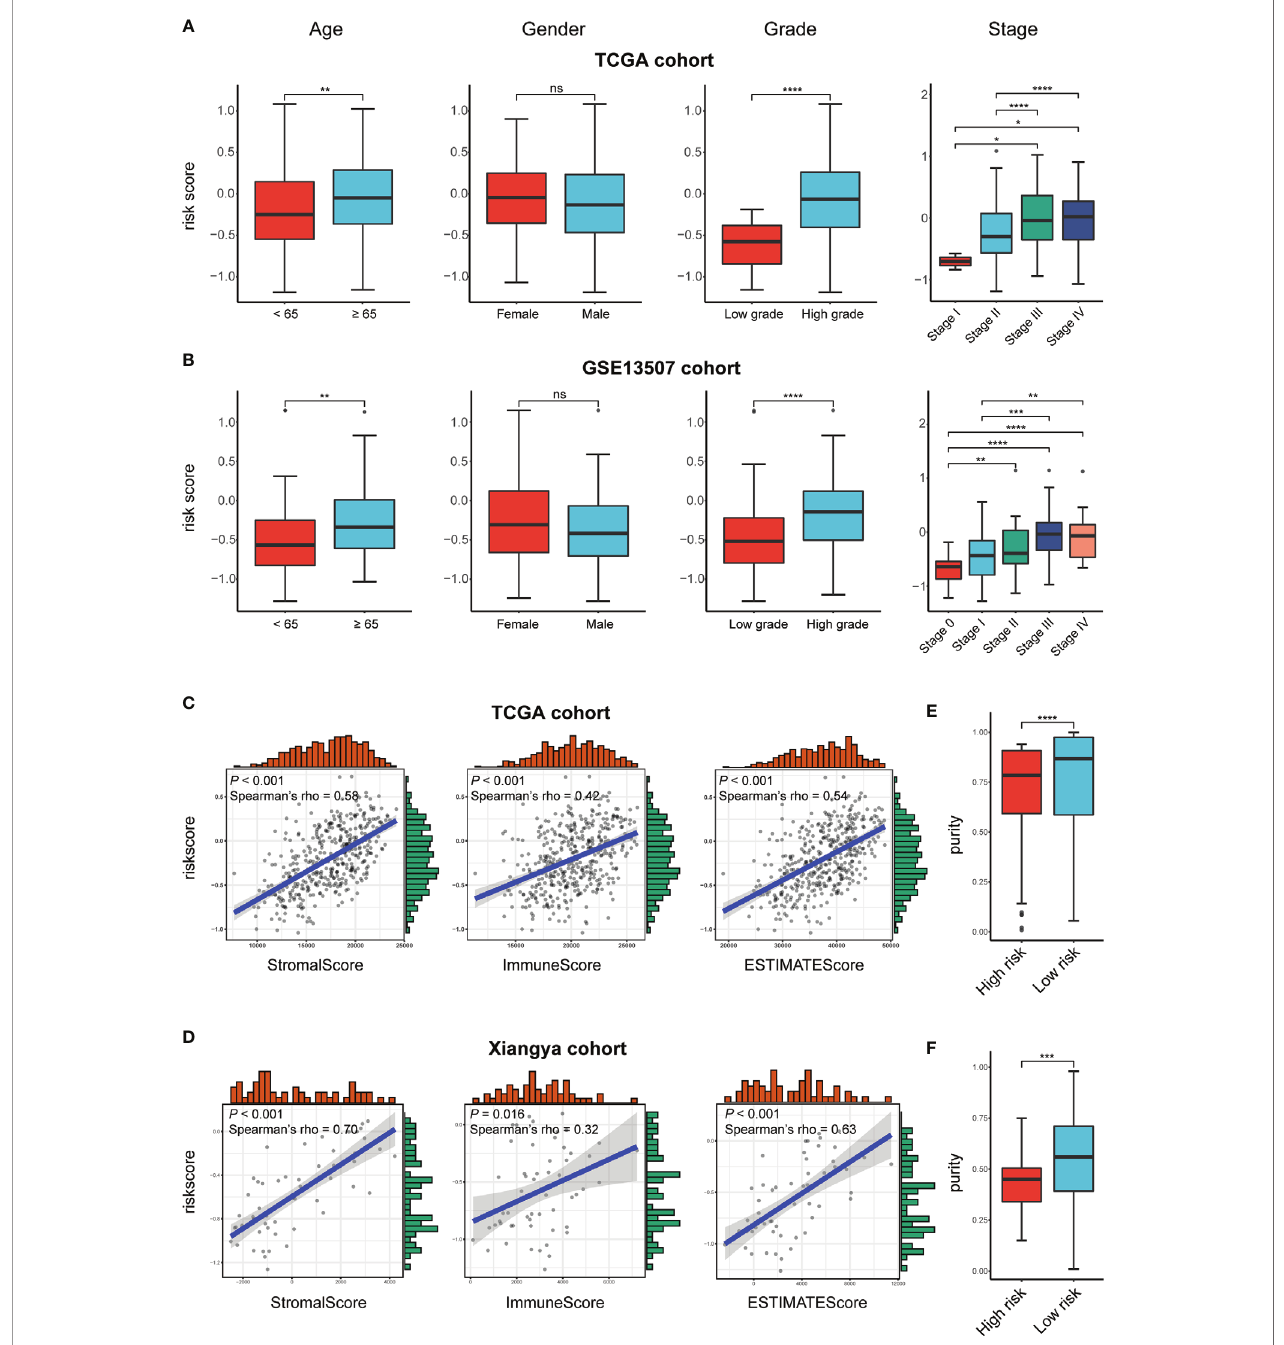
FIGURE 7 | Exploration the relationship between clinicopathologic features, immune purity, and the risk signature. (A, B) Risk scores of different subgroups for age, gender, WHO grade, histologic stage in TCGA BLCA and GSE13507 cohorts. (C, D) The correlation between stromal, immune, and ESTIMATE scores and risk score in the high- and low-risk groups in TCGA BLCA and GSE13507 cohorts. (E, F) Tumor purity between high- and low-risk groups in TCGA BLCA and Xiangya cohorts. *P < .05, **P < .01, ***P < .001, ****P < .0001. ns, not signi fi